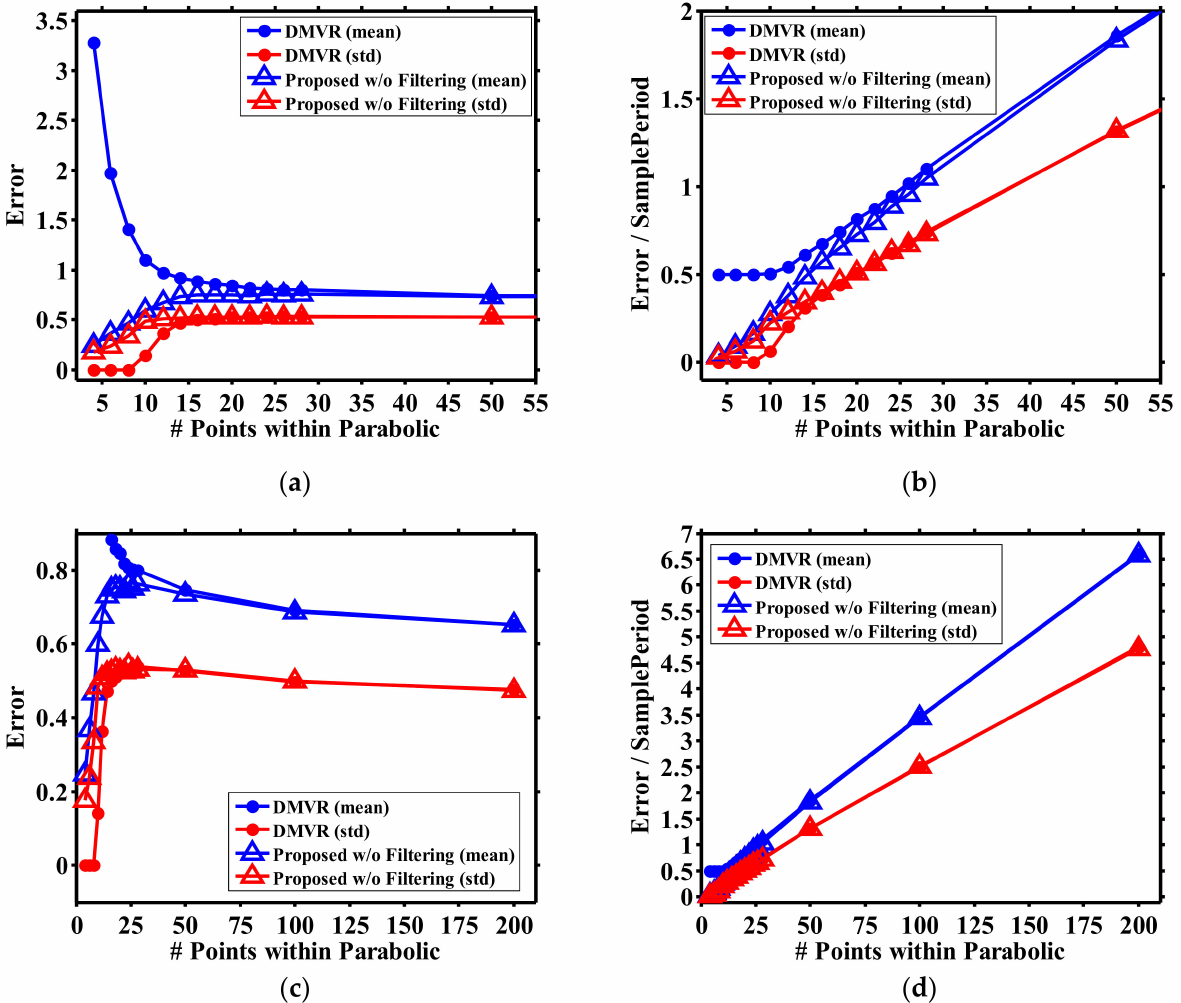
Figure 4. Peak detection performance at SNR = 30 dB. ( a – d ) are, respectively, plotted with the same data, but enlarged at different regions of the coordinate